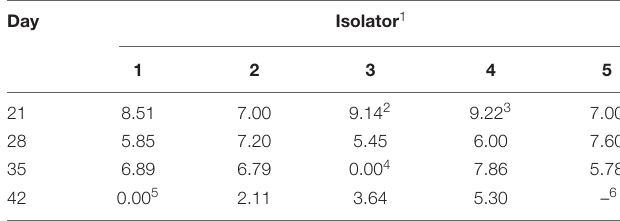
TABLE 1 | Salmonella abundance in chicken ceca at 21, 28, 35, and 42 days